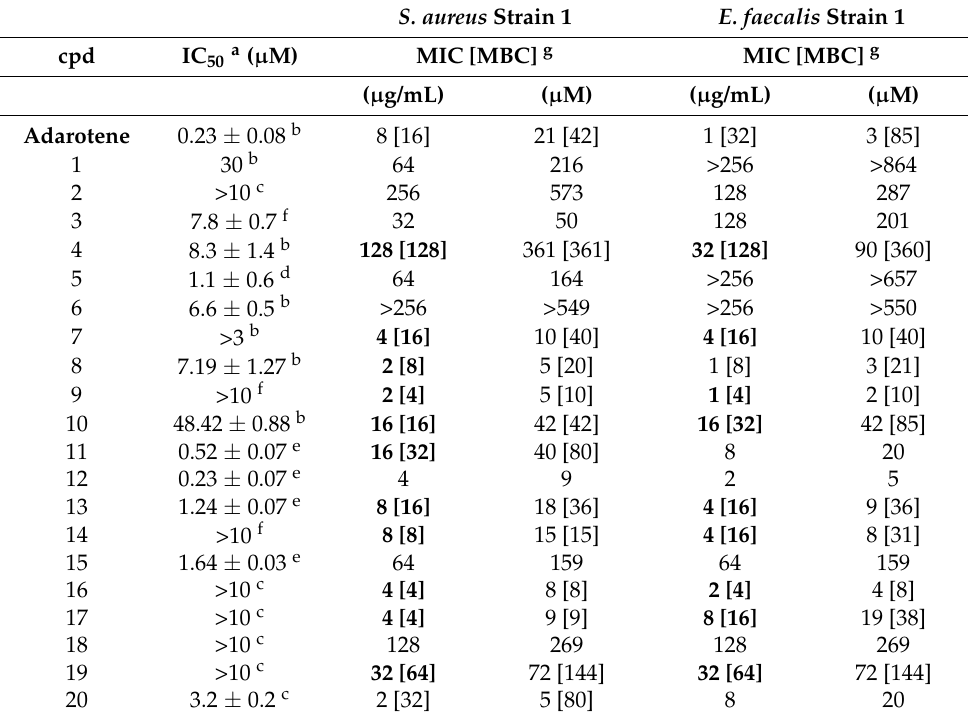
Table 1. Antimicrobial activity of adarotene derivatives 1 – 20 against MDR clinical strains of S. aureus and E. faecalis and cytotoxic